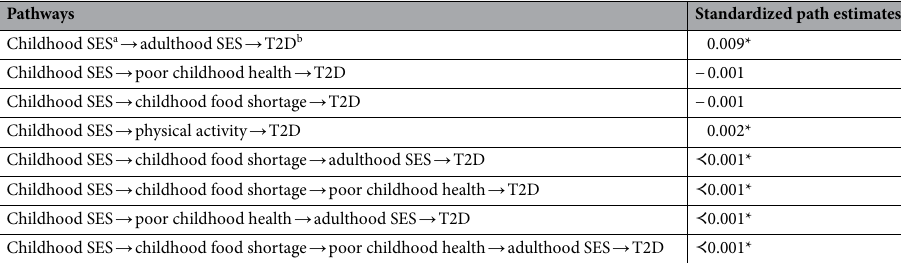
Pathways Standardized path estimates